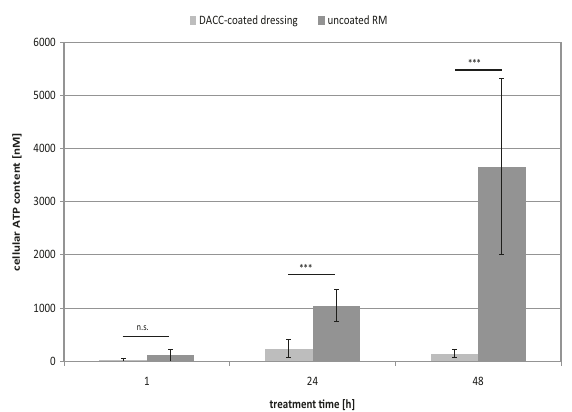
Fig. 2 Comparison of NHDF adherence to the DACC-coated dressing samples and uncoated RM determined by measurement of the cellular ATP-content using the luminometric ATP assay. Asterisks indicate a signi fi cant deviation between DACC-coated dressing and uncoated RM (* p < 0.05; ** p < 0.01; *** p < 0.001), while n.s. designates “